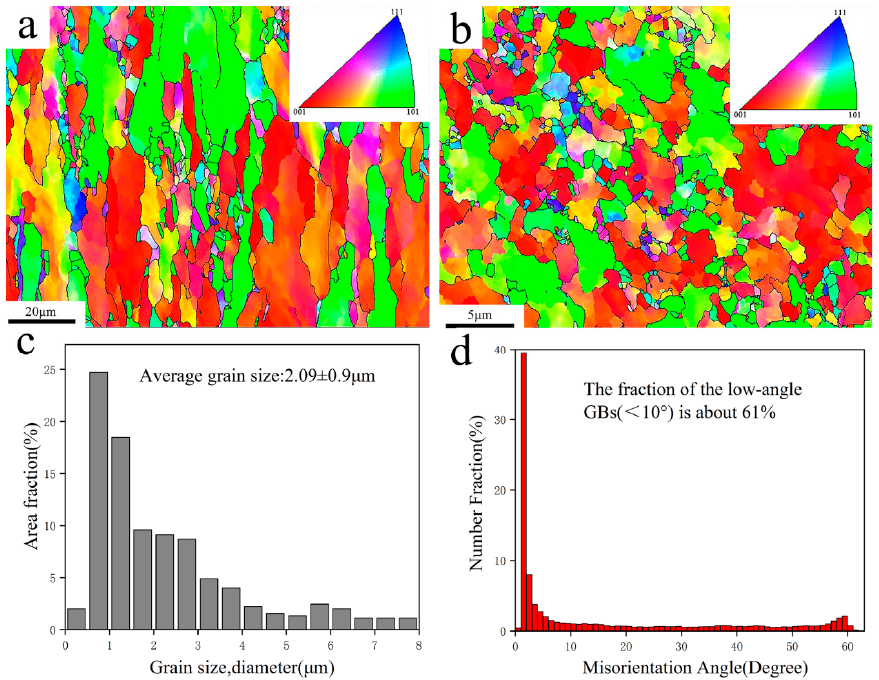
Figure 4. EBSD images of Ni@CNTs/Cu composites: ( a ) test plane parallel to the drawing direction, ( b ) test plane perpendicular to the drawing direction. ( c ) Grain size distribution of ( a , d ) Grain boundary orientation difference distribution of ( a ).